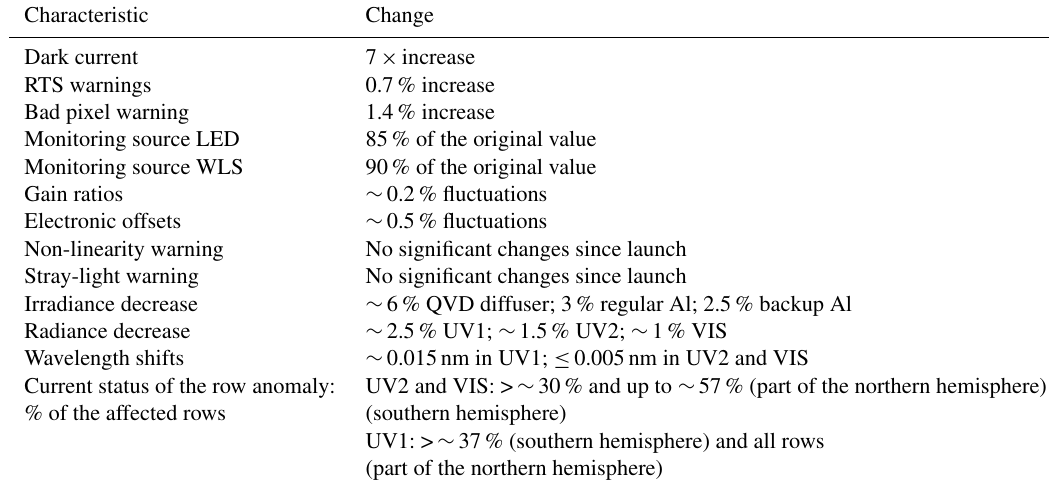
Table 7. OMI performance over the mission time, year 2005–2015.